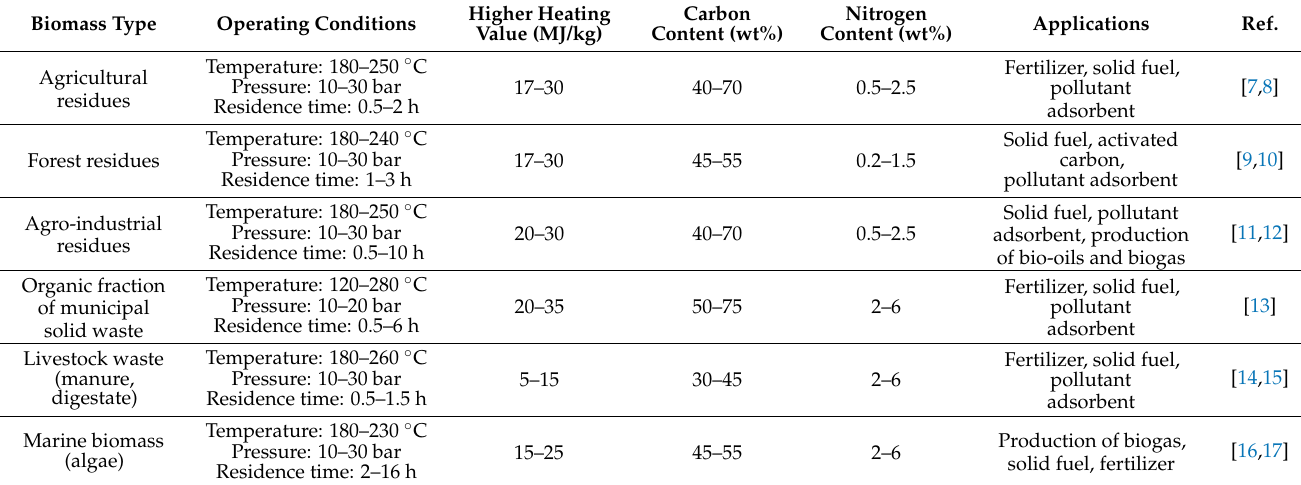
Table 1. Applications and properties of hydrochar from different biomass